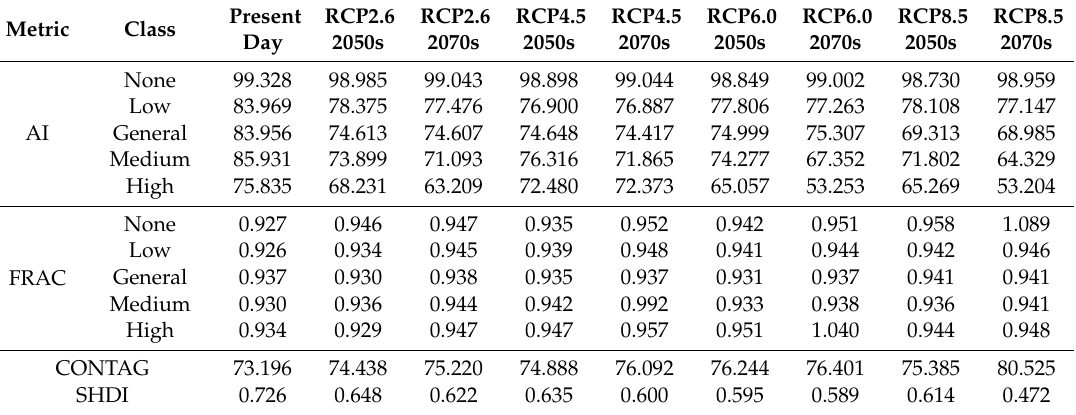
Table 5. Landscape metrics of the suitable distribution area for Cunninghamia lanceolata for the present day, 2050s and 2070s under di ff erent climate change